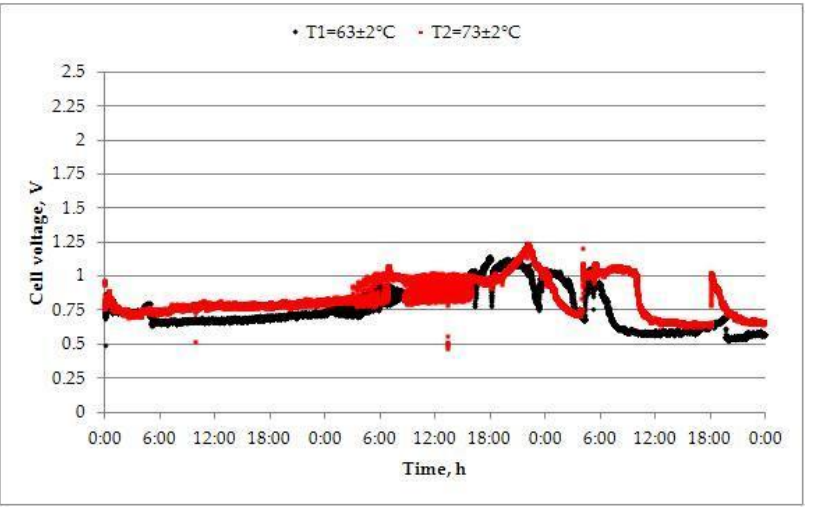
Figure 2. Cell voltage changing during the electrorefining of the anode with sample code An-2, for different working electrolyte temperatures, 72 h duration.